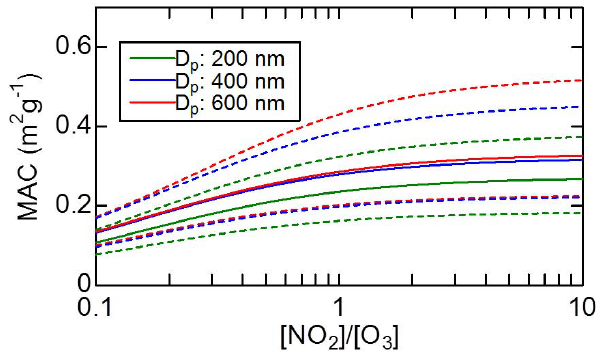
Fig. 9. [NO 2 ]/[O 3 ] dependence of the MAC values at 405nm for the toluene-SOAs with particle diameters of 200, 400, and 600nm, as- suming a constant [NO]/[NO 2 ] (=0.04). The solid and dashed lines are the best estimation and upper (or lower) limit values, respec-